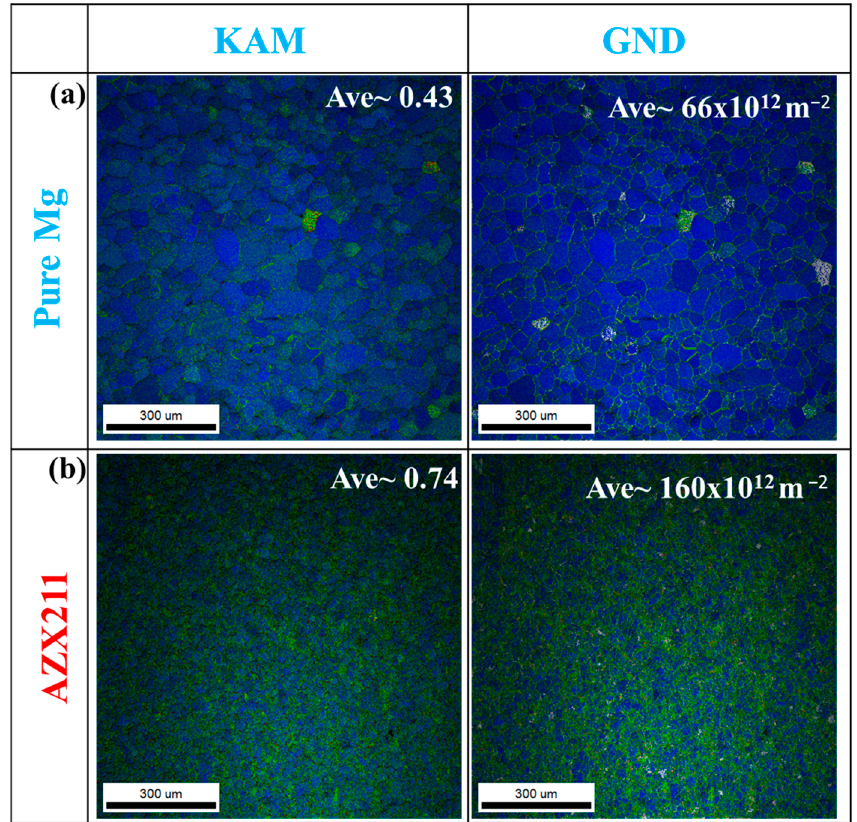
Figure 2. Kernel average misorientation (KAM) and geometrically necessary dislocation maps for ( a ) pure Mg and ( b ) AZX211.